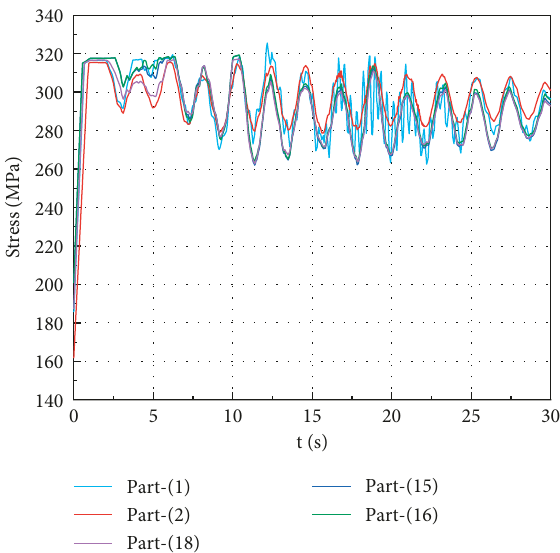
Figure 31: Stress-time curve of each shackle.